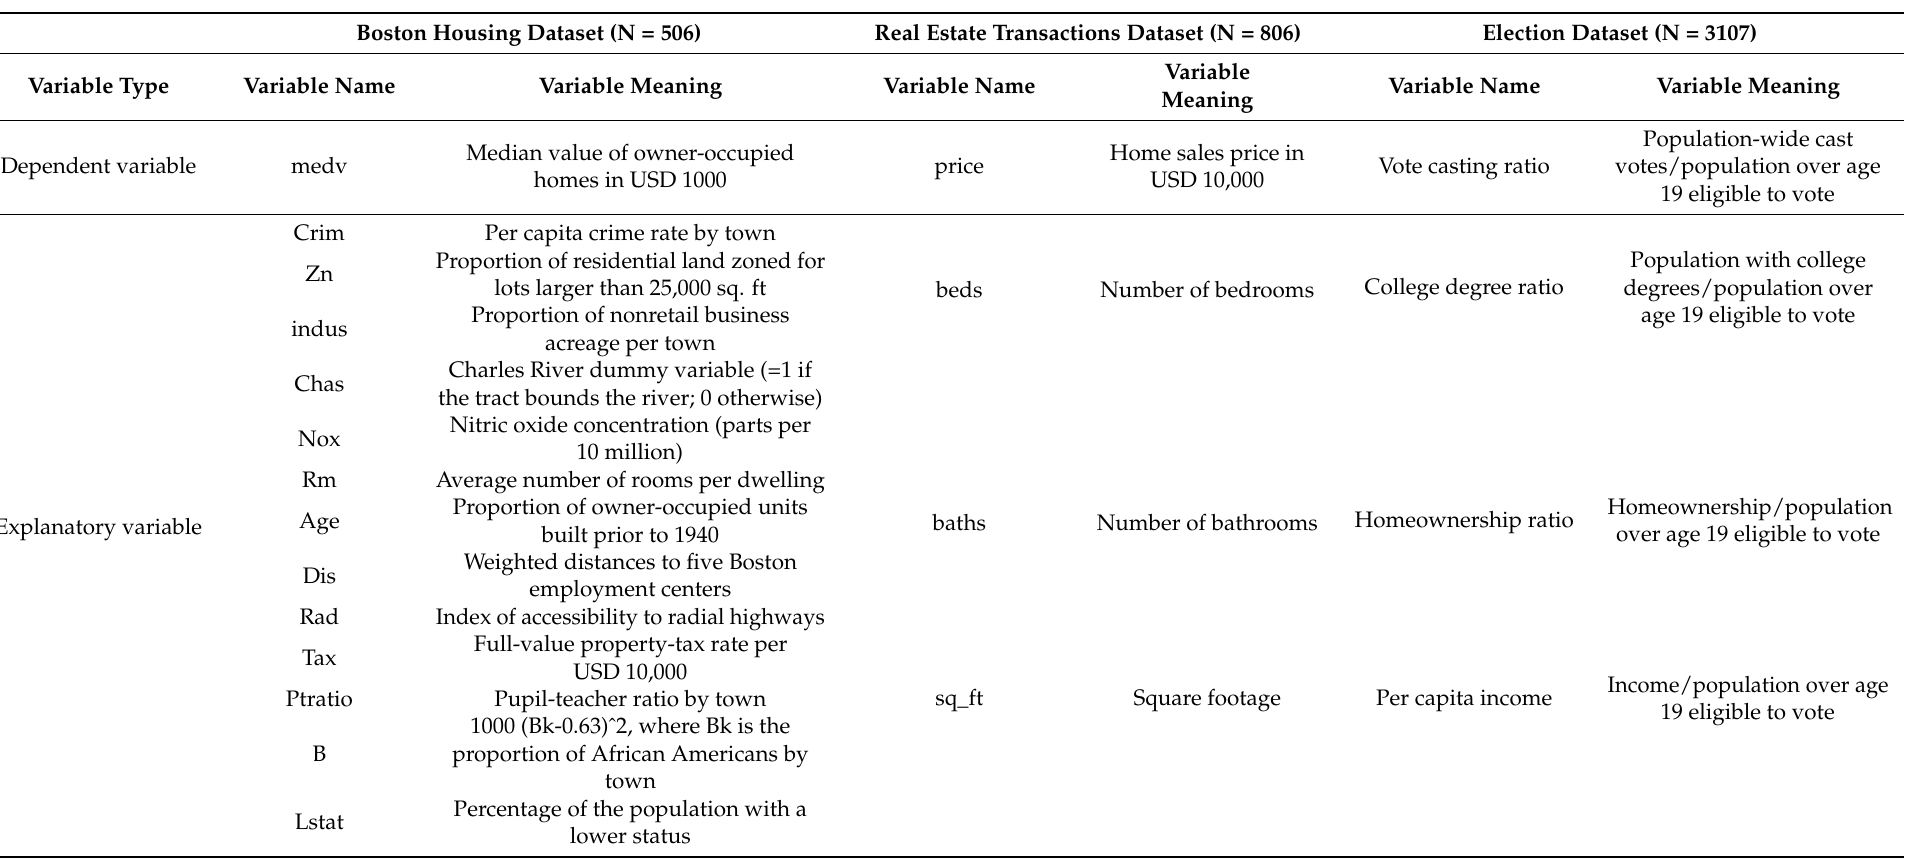
Table 1. Variable information on the three